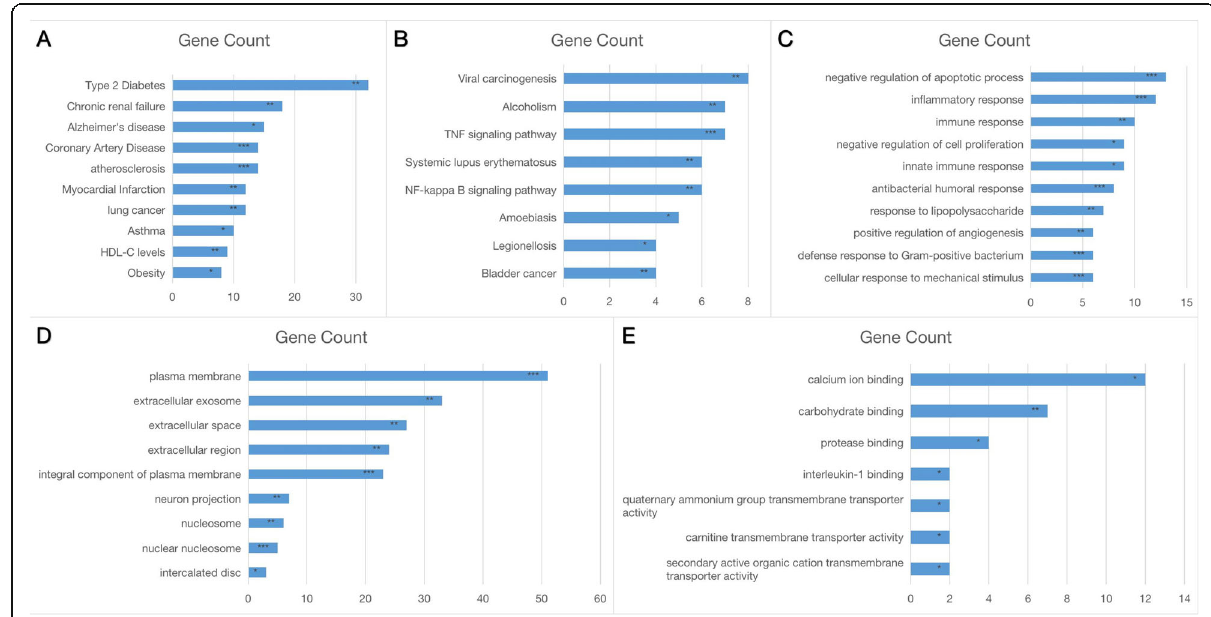
Fig. 4 Functional enrichment analysis of meta-DE genes. (A) GAD-disease analysis. (B) KEGG pathway enrichment analysis. (C)